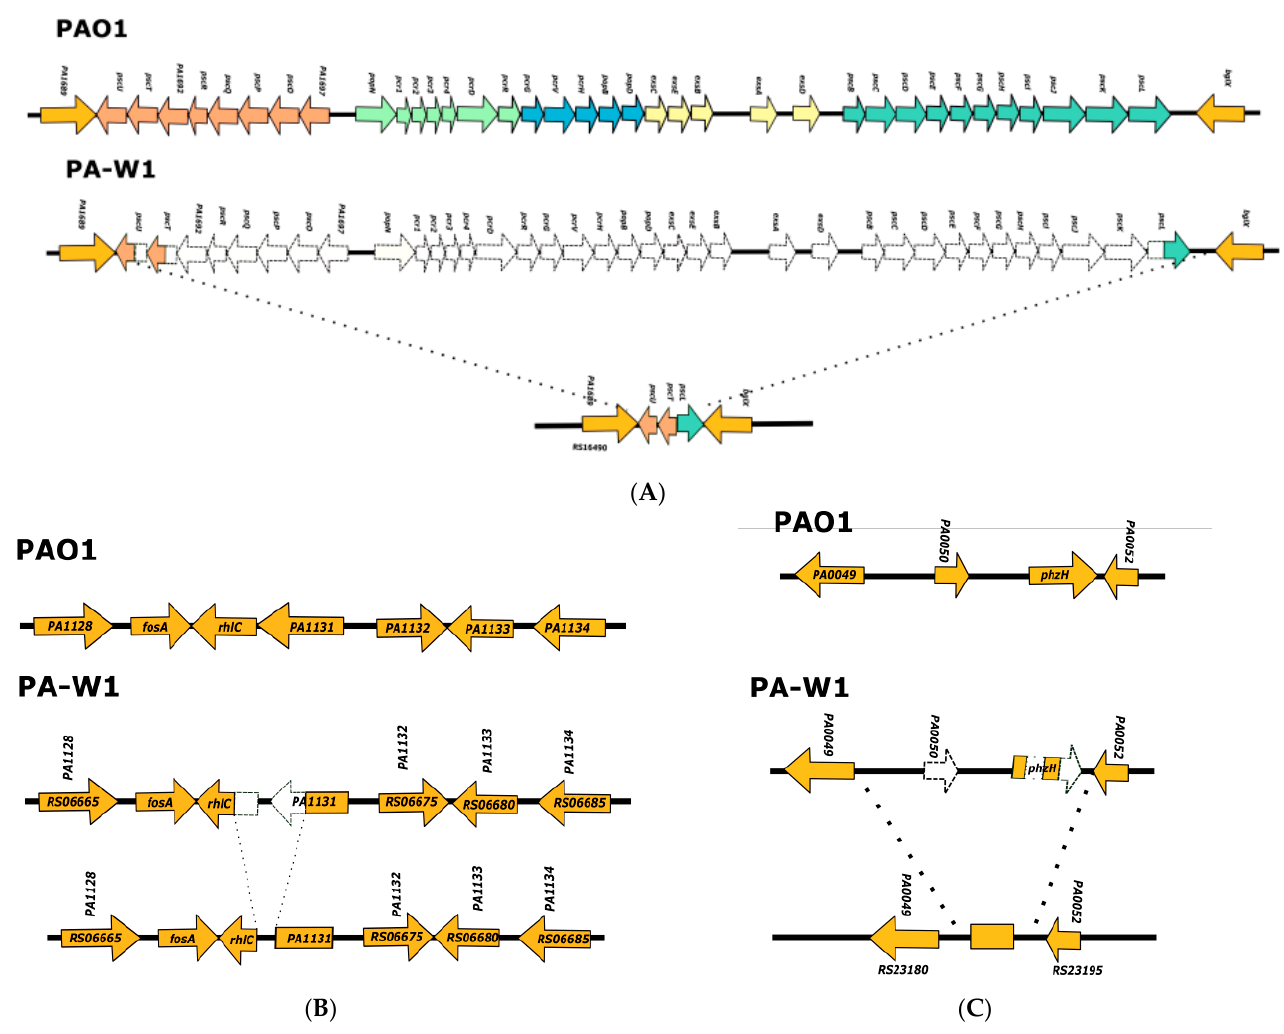
Figure 3. Analysis of PA-W1 genome regions where the genes involved in T3SS, rhlC, and phzH are encoded in the PAO1 strain. ( A ) Representation of the PAO1 and PA-W1 chromosomal regions where genes involved in the T3SS are encoded in the former strain; ( B ) representation of the PAO1 and PA-W1 chromosomal regions where rhlC is encoded in the former strain; ( C ) representation of the PAO1 and PA-W1 chromosomal regions where phzH is encoded in the former strain. Color codes used are the same as in Figure 2.